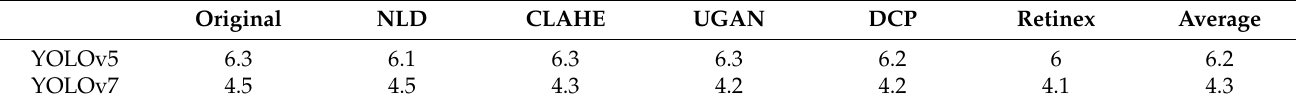
Table 7. Prediction time of YOLOv7 and YOLOv5 (unit: ms).